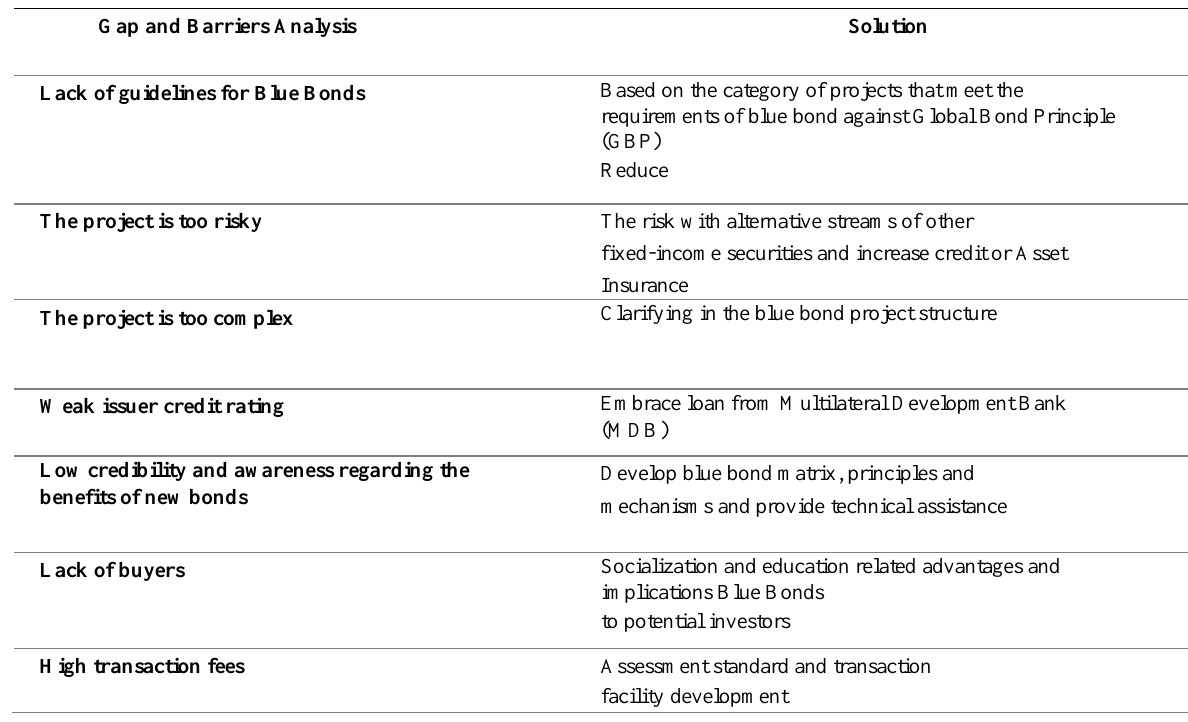
Table 2: Gap and Barriers Analysis Blue